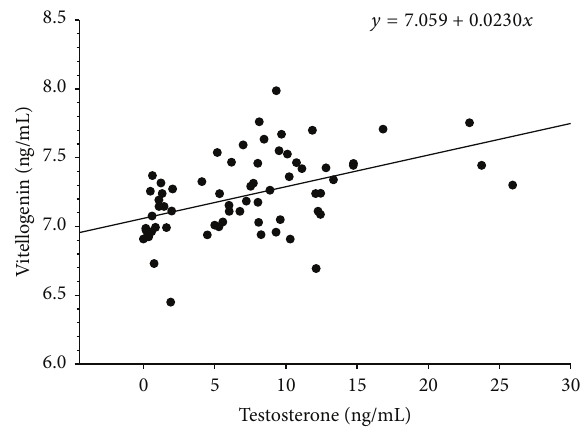
Figure 5: Plasma testosterone concentration in relation to log vitel- logenin concentration in nesting females. There was a significant positive linear correlation between vitellogenin and testosterone concentration ( r 2 = 0.225, 𝑃 < 0.001 , 𝑛 = 67